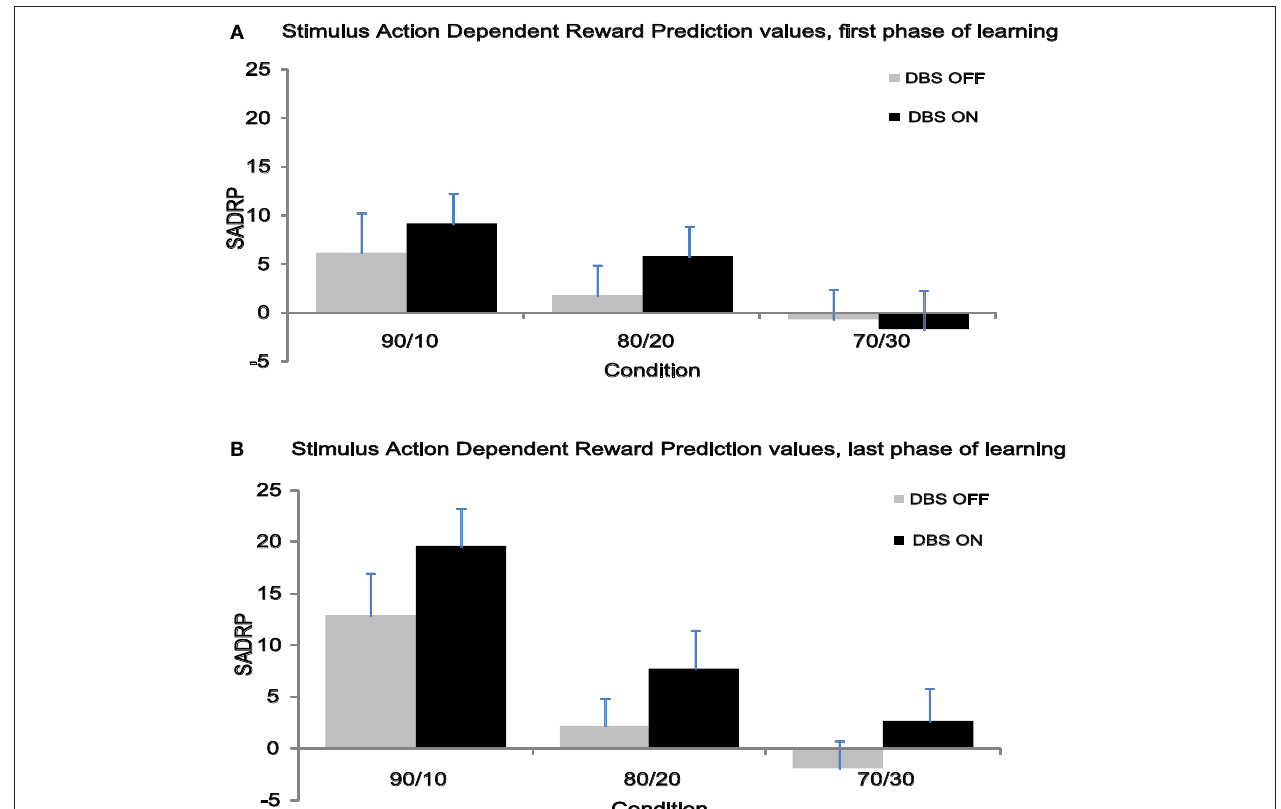
Figure 4 | (A) Mean SADRP values from the first 24 trials separate for each condition. (B) Mean SADRP values from the second 24 trials separate for